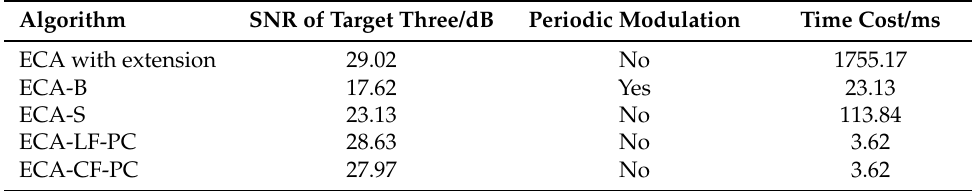
Figure 6. The two-dimensional cross-correlation function’s Doppler slice of different ECA versions: ( a ) global view and ( b ) zoomed-in view. Table 3. Performance of different ECA